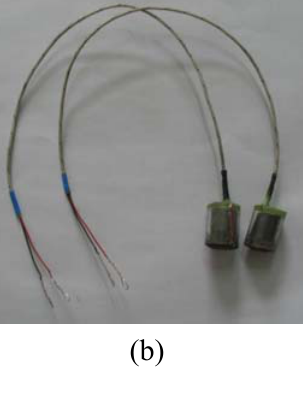
Figure 1. (a) Schematic layout of the chloride sensor structure. (b) Photograph of the completed chloride